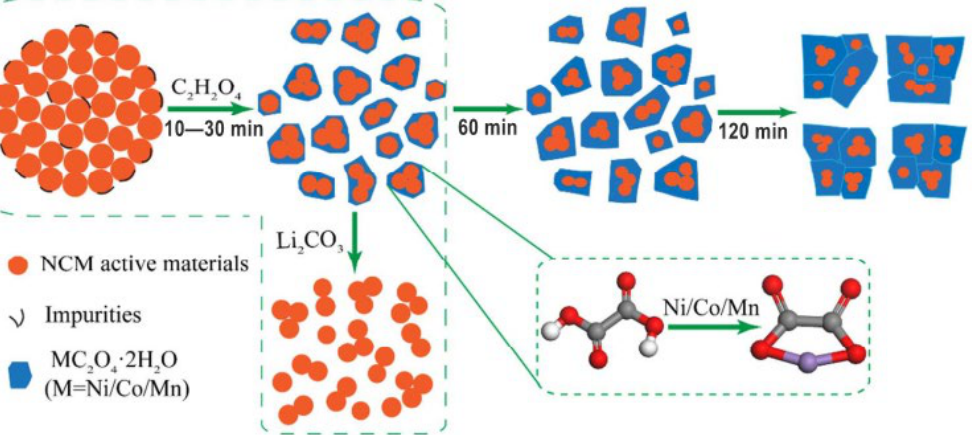
Figure 3. Schematic of the proposed regeneration process of waste NCM cathode materials using environment-friendly oxalic acid. Reprinted with permission from Ref. [52], Copyright 2018, American Chemical Society.